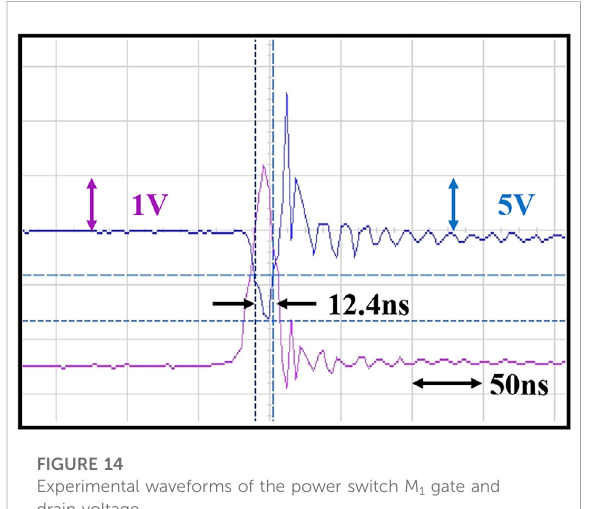
FIGURE 14 Experimental waveforms of the power switch M 1 gate and drain